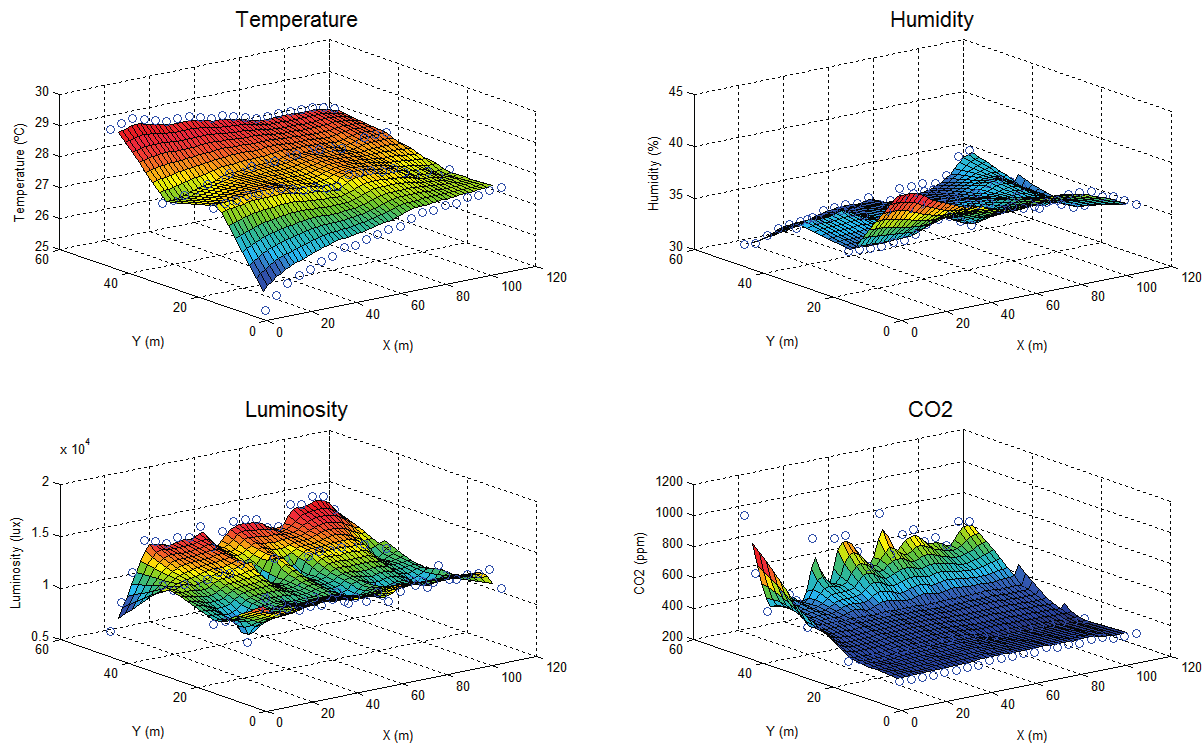
Figure 11. Maps of temperature, humidity, luminosity and CO 2 concentration of the greenhouse. In contrast, the humidity declined from 43% to 33% from the beginning to the end of the experiment at the same locations as the temperature measurements. This behavior is also justified by considering the differences between nighttime and daytime humidities. Additionally, the values of humidity (e.g., 30%–50%) were lower than is typical in greenhouses (e.g., 70%–90%); this was likely from the evapotranspiration of plants was